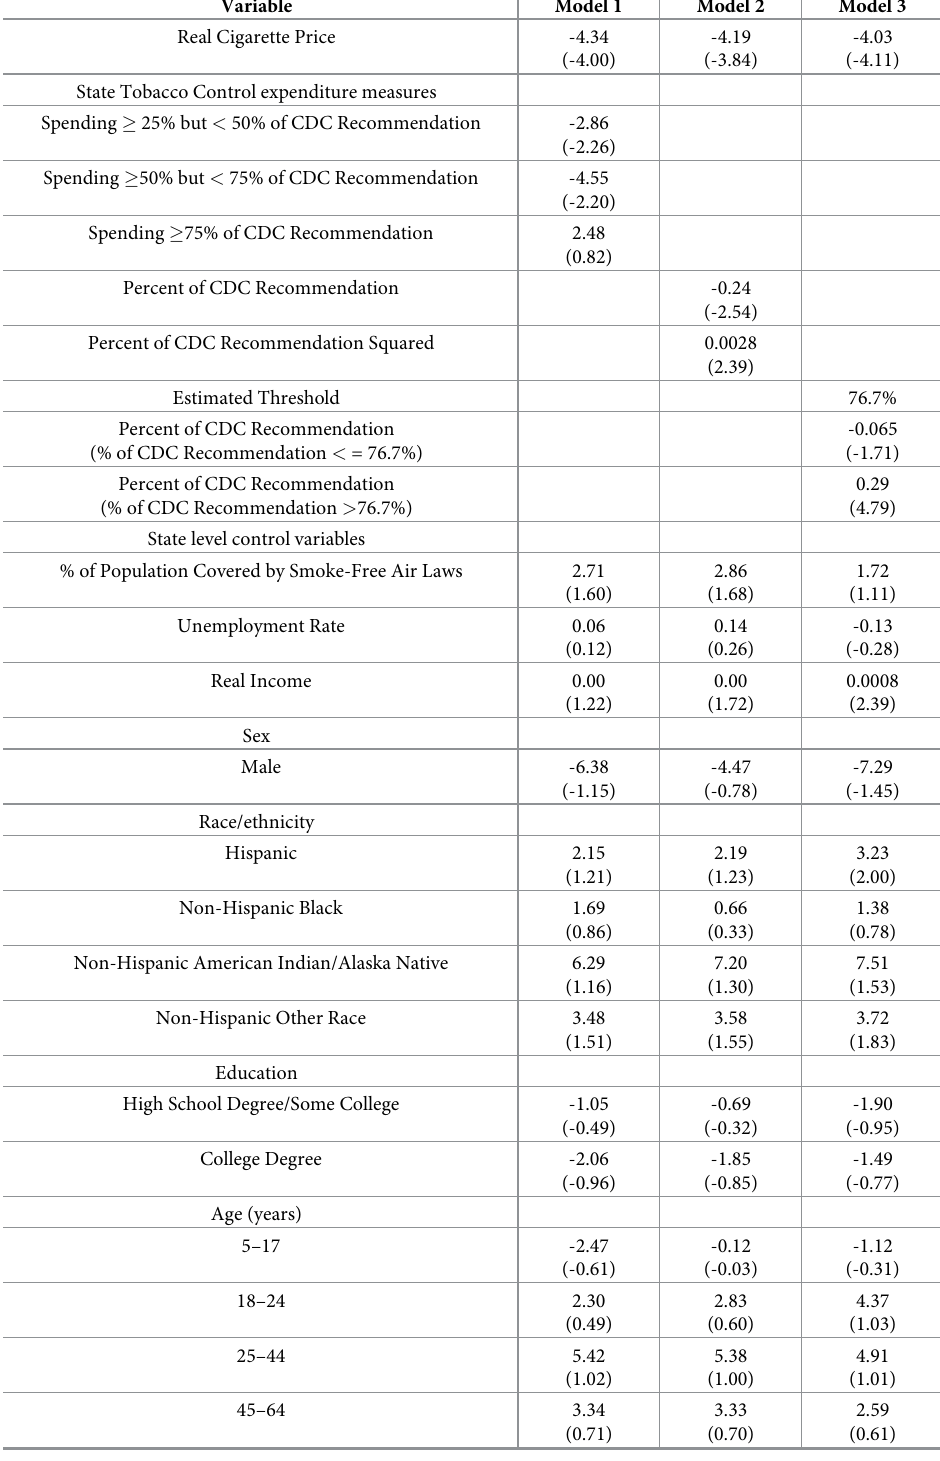
Table 2. Impacts of state tobacco control expenditures on Per Capita cigarette sales: United States for years 2008–